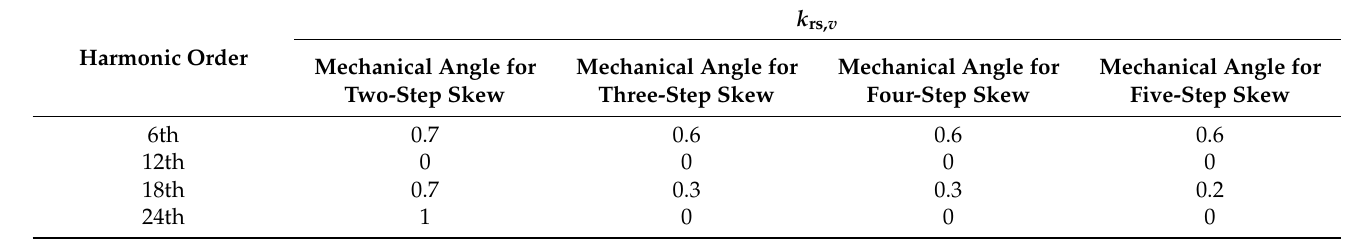
Table 13. Value of the mitigation factor when the 18th harmonic component is selected to reduce ( w = 18 ) .